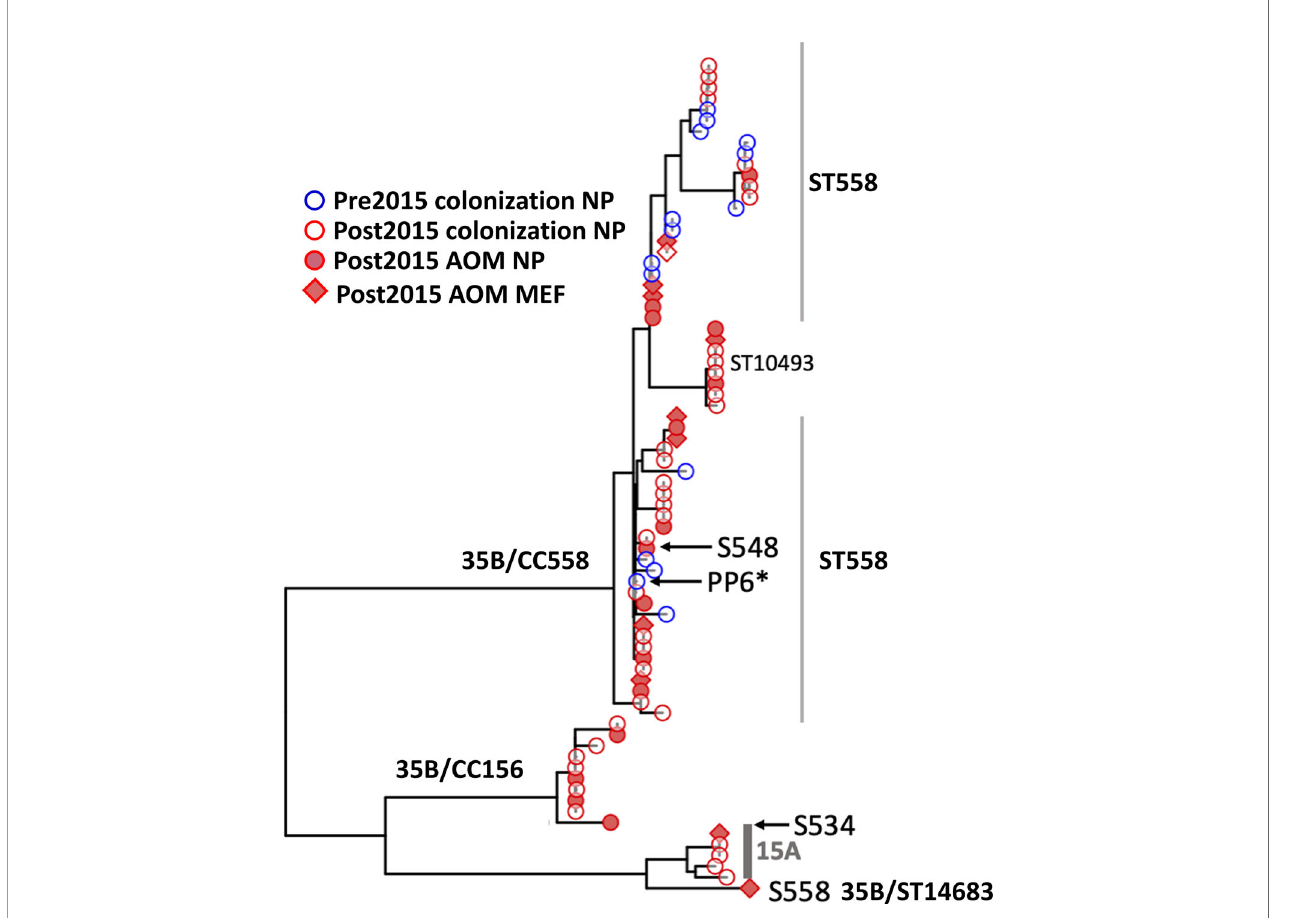
FIGURE 3 | Phylogenetic tree of all 35B isolates based on core protein coding genes from WGS analysis. This phylogeny contains all of the ST558 35B strains sequenced for this study. The strains marked in blue circle were isolated prior to 2015 from colonization and red circle were after 2015 from colonization. Filled red circle represents strains isolated during AOM infections from NP, and fi lled square represents isolated during AOM from MEF. PP6 used as the reference strain was marked with *. S558 is the 35B/ST14683. The two representative parental strains used for the further analysis to see recombination breakpoints were marked by arrow (S548: 35B/ST558, S534: